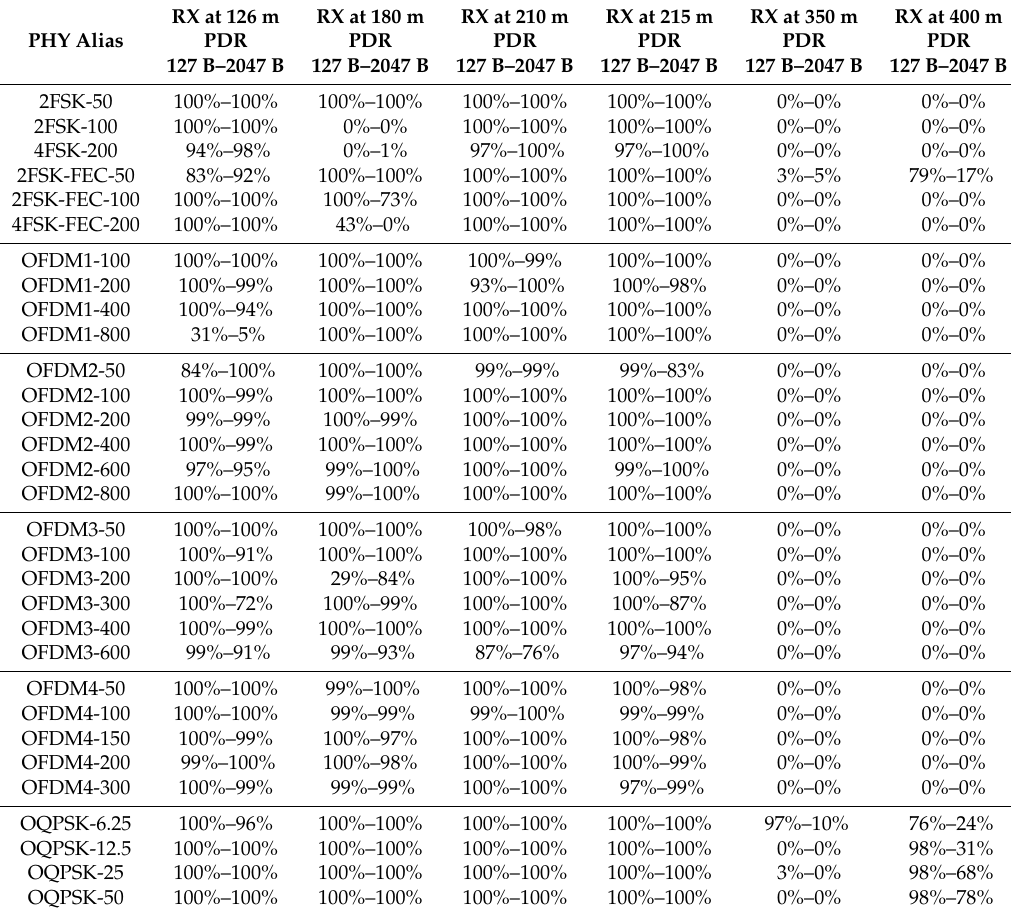
Table 11. AMI. PDR for packets of 127 B and 2047 B long. Even without LoS, high data rates can be achieved up to 215 m with the maximum packet length. At 350 m and 400 m, the PDR decays due to the multiple buildings between TX and RX